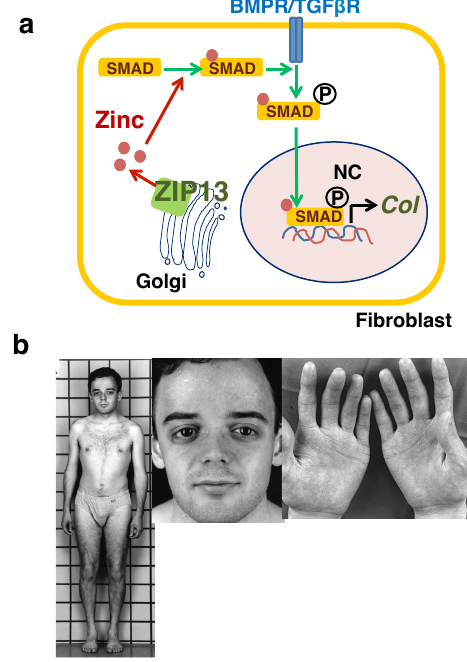
Figure 4. Ehlers–Danlos syndrome spondylodysplastic type 3 is caused by impaired collagen production due to ZIP13 dysfunction. ( a ) ZIP13 supplies zinc (brown circle) to SMAD proteins for their nuclear translocation. Phosphorylatoin is depicted as circled P. ( b ) The elder affected sib is shown at age 22 years. Patient exhibits short stature with mildly shortened trunk, antimongoloid eye slant with lack of periorbital tissue, thin and finely wrinkled skin on the palms of the hands. BMPR/TGF β R, BMP receptor/TGF- β receptor; Col , collagen. Modified from Fukada et al.